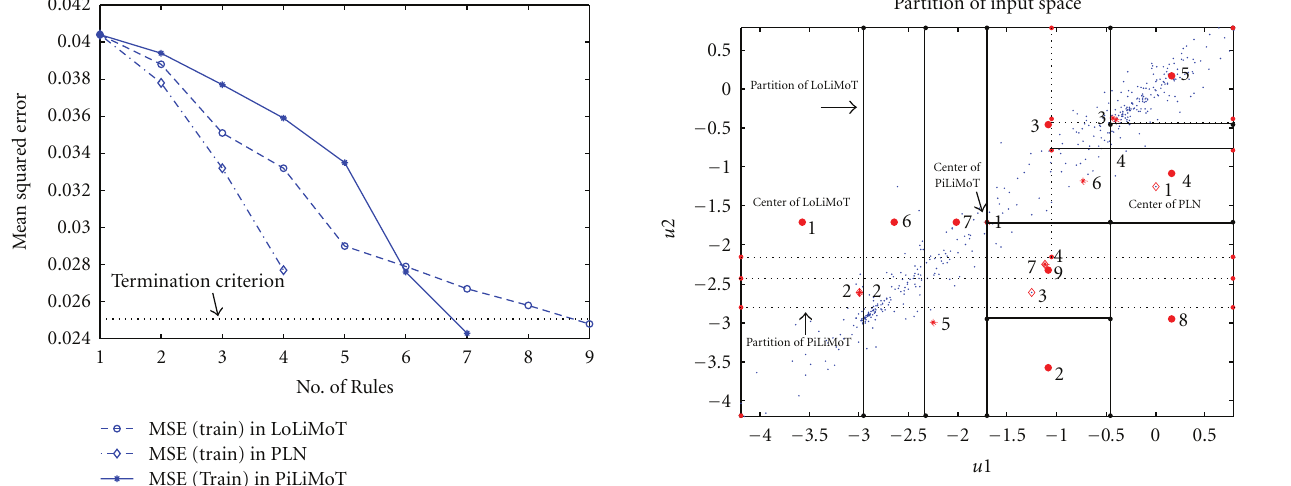
Figure 4: Convergence curves in comparing original LoLiMoT and original PLN with new combined learning algorithm in training data. In first steps, new combined learning algorithm has worse performance than original LoLiMoT because of the irregular choice of new center for new local linear model, but after some steps it has better performance.